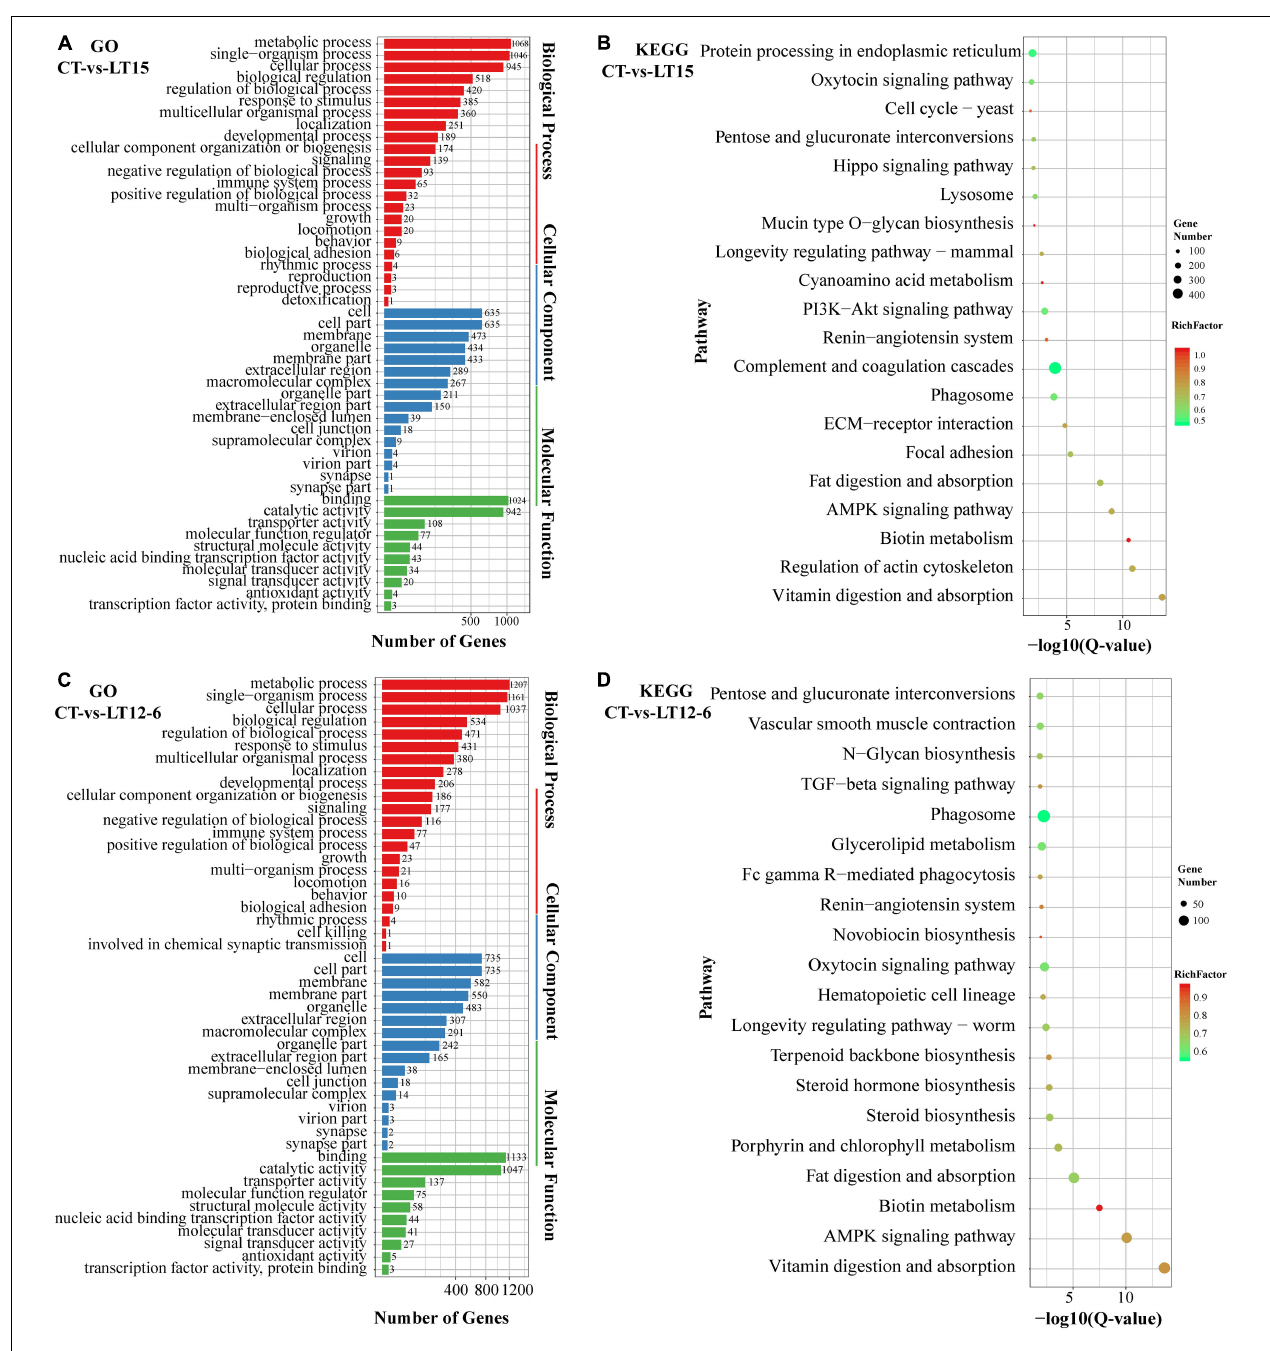
FIGURE 5 | Summary of GO and KEGG pathway enrichment analyses of DE miRNAs in the CT vs. LT15 (A,B) and CT vs. LT12-6 (C,D)